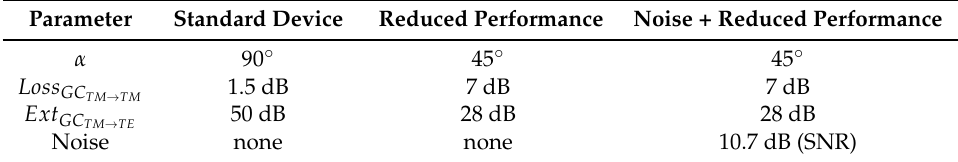
Table 3. Showing parameters that are dependent on the device